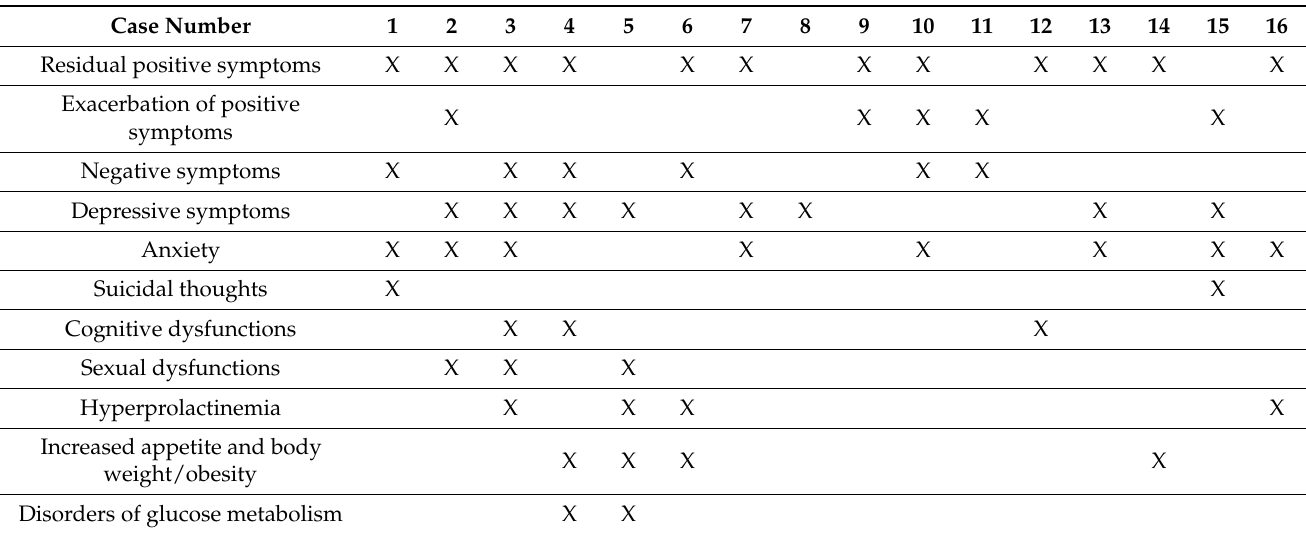
Table 3. Characteristics of the psychopathological symptoms and somatic conditions presented by schizophrenia patients before initiation of lurasidone augmentation of